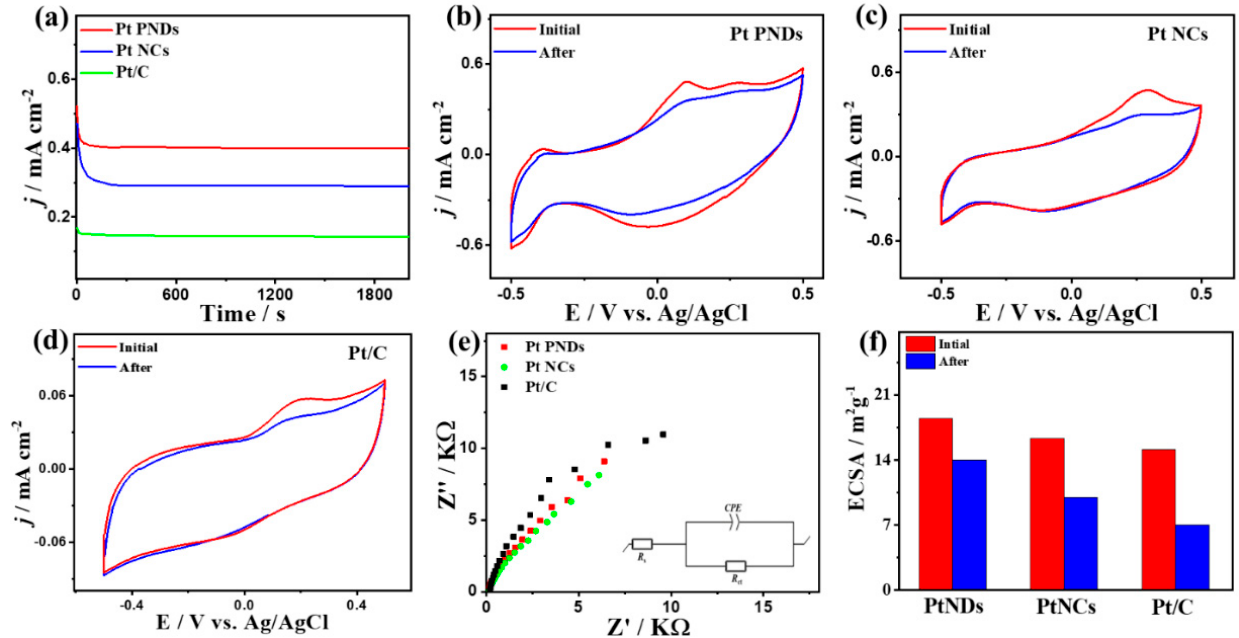
Figure 8. ( a ) CA tests measured on Pt NDs, Pt NCs, and Pt/C in CO-saturated 0.5 M NaHCO 3 . CV curves measured after CA on ( b ) Pt NDs, ( c ) Pt NCs, and ( d ) Pt/C. ( e ) EIS and ( f ) ECSA stability.